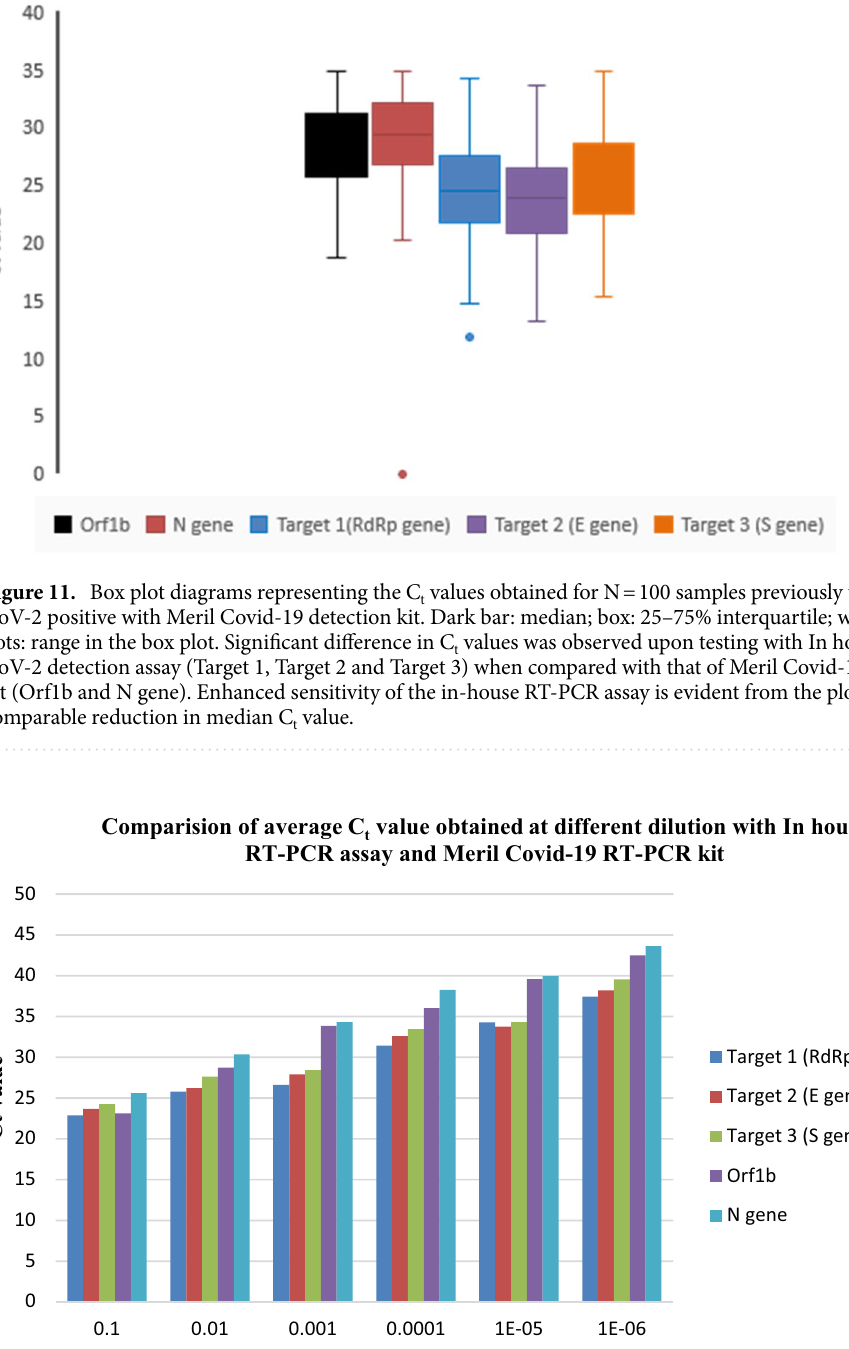
PCR assay protocol needed 67 min after RNA extraction and cDNA synthesis. With the HRM coupled multiplex RT-PCR based detection, a time of 96 min was needed post RNA extraction and cDNA synthesis.